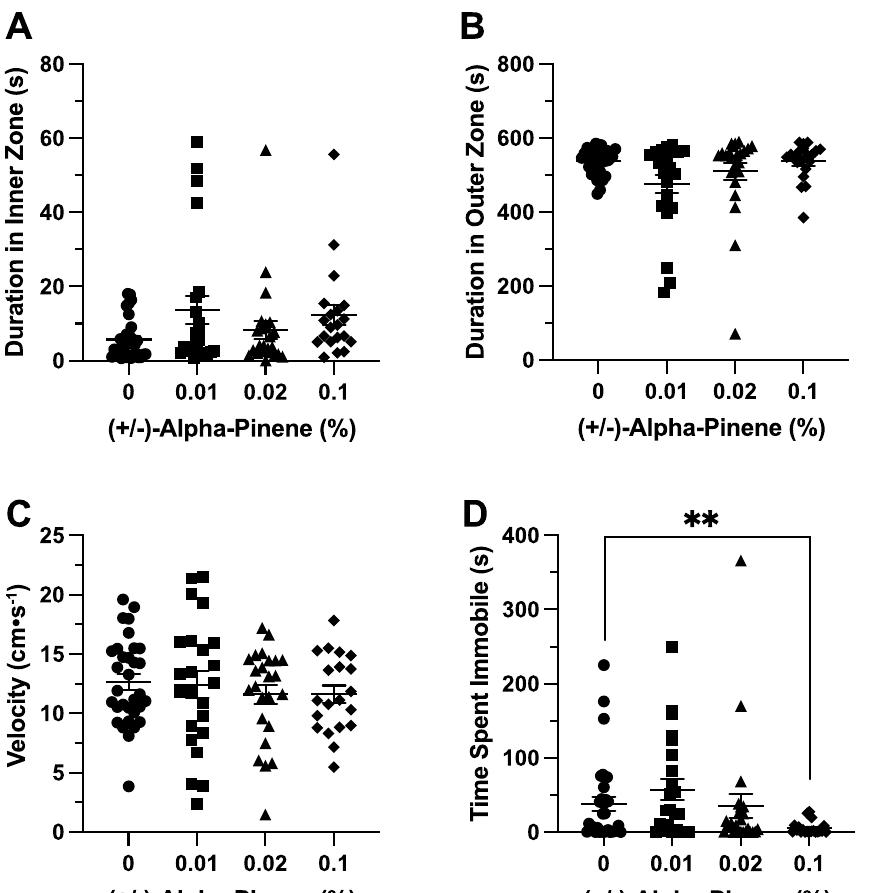
Figure 2. The effects of (+ /−)-alpha-pinene administration in the open field test. Average duration of time fish spent in the ( A ) inner and ( B ) outer, ‘thigmotaxis’ zone during the open field test. Fish locomotion was quantified in the open field test by measuring ( C ) swimming velocity and ( D ) time spent immobile. All data are presented as mean ± S.E.M. Significant differences between controls and (+ /−)-alpha-pinene treated groups are indicated by **( p <